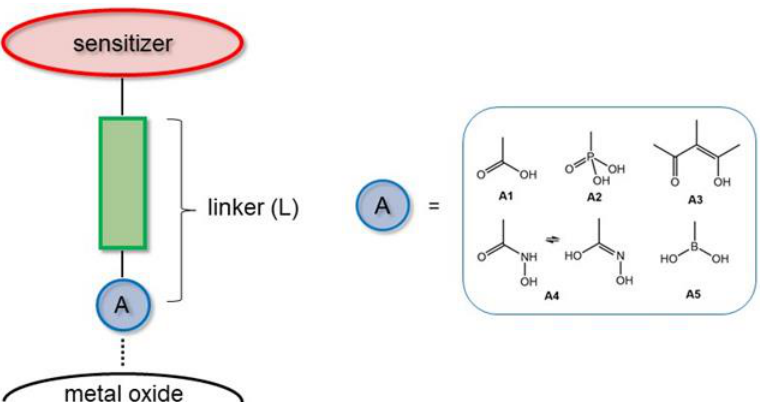
Figure 1. Linker molecules (L) are replaced with different anchoring groups A: carboxylic acid (A1), phosphonic acid (A2), acetyl acetonate (A3), hydroxamic acid (A4), boronic acid (A5).